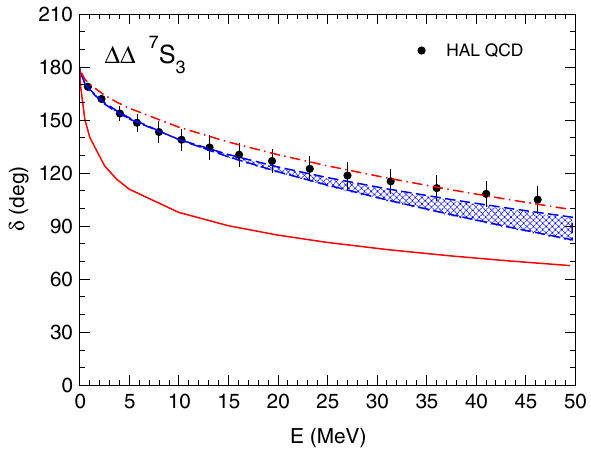
Fig. 5 Prediction for the ΔΔ 7 S 3 phase shift with isospin I = 0. The result of the HAL QCD collaboration is taken from Ref. [21]. Results of a fit to the lattice simulation is shown by a hatched band, corresponding to cut-off variations between 500 and 700 MeV. The corresponding results for physical masses are shown by solid (700 MeV) and dash- dotted (500 MeV)